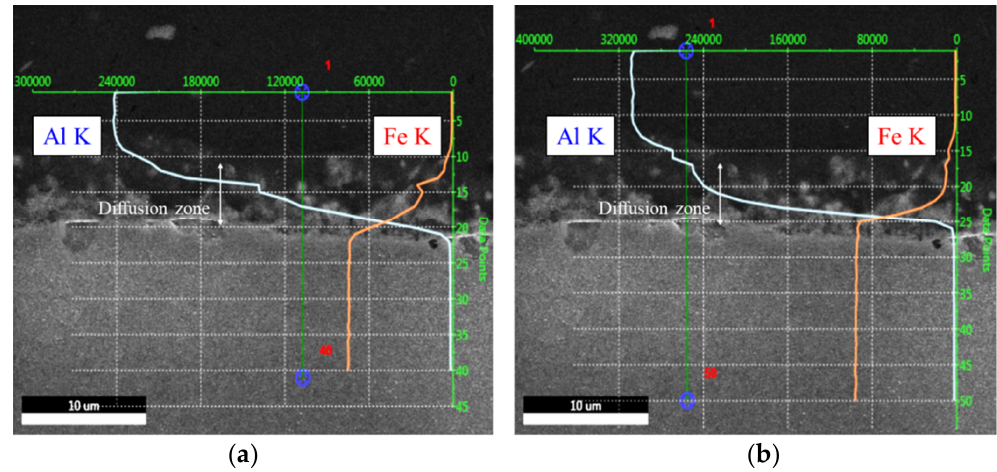
Figure 16. SEM-EDS results about composition at the interface area: ( a ) in specimen-1; ( b ) in specimen-2.